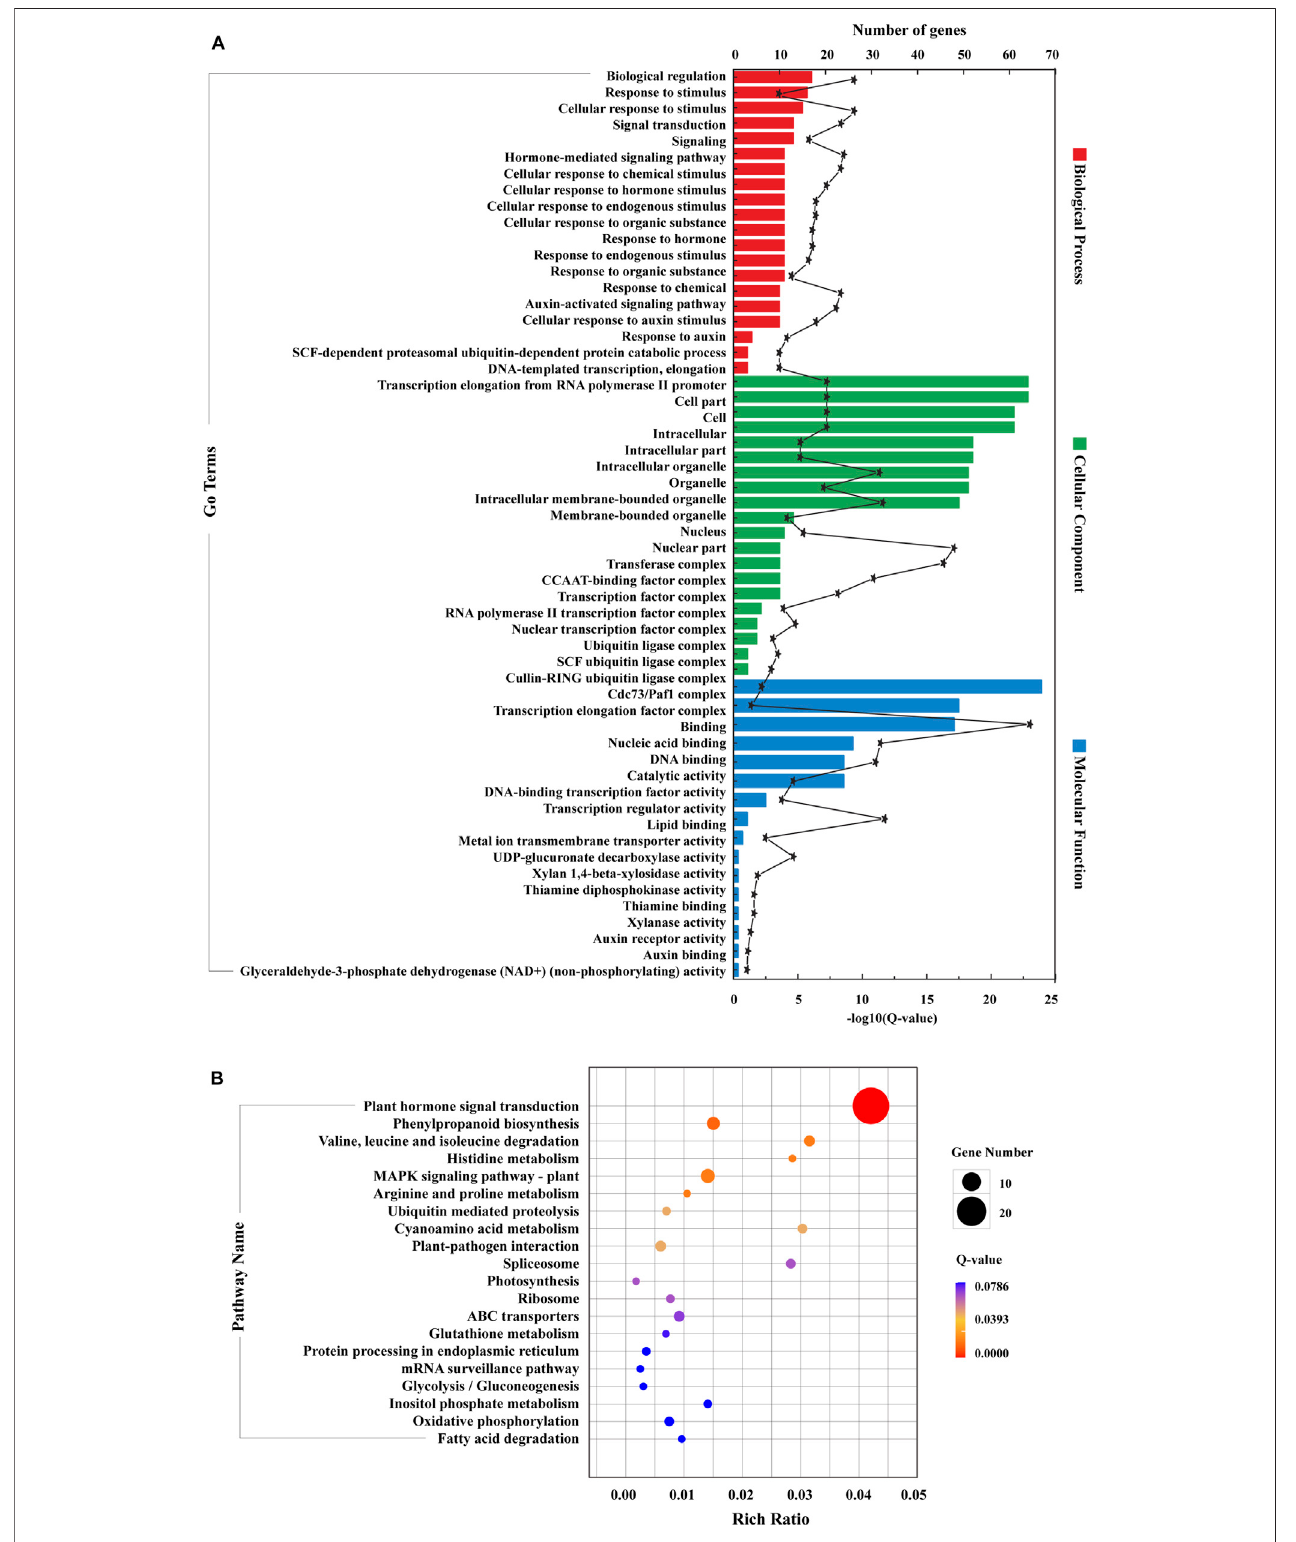
FIGURE 7 | GO (A) and KEGG (B) classi fi cation of target genes that comprised the co-expressed miRNA-target regulatory network. For GO-based enrichment analysis, the 20 most abundant subcategories of each category (biological processes, cellular components and molecular functions) were listed and the fi rst 20 signi fi cantly enriched pathways were presented for KEGG analysis. All the enrichment items were listed if the total was less than 20.